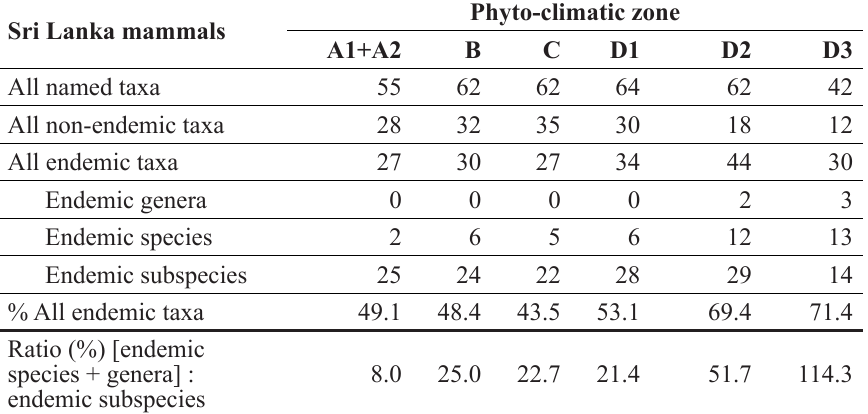
Table 4: Comparison of the distribution of non-endemic and endemic mammal taxa (genera, species and subspecies) and the rates of taxonomic differentiation across different phyto-climatic